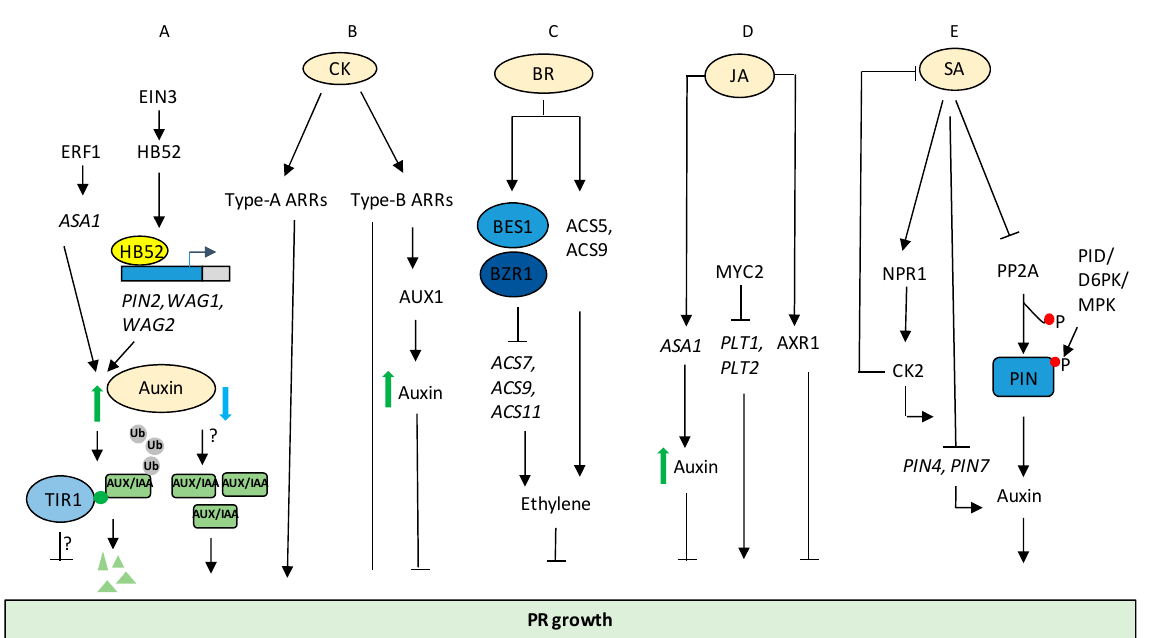
Figure 2. Regulation of primary root (PR) growth by various hormones and their crosstalk. ( A ) Auxin effects root growth in a concentration-dependent manner and interacts with ET signalling pathway to control PR elongation. Low concentration of auxin promotes PR growth probably via free AUX/IAAs, while high concentration inhibited PR growth through TIR1-mediated signalling via an unknown non-transcriptional mechanism ( B ) CK signalling modulates PR growth via AUX-1 mediated auxin translocation. ( C ) BR induces ET production via stabilizing ACS5, and ACS9 represses ET synthesis through BES1 and BZR1-mediated repression of ACS7 , ACS9 , and ACS11 to control PR growth. ( D ) MYC2, a DNA binding bHLH transcription factor in JA signalling, represses the transcriptional expression of PLT1 and PLT2. JA regulates expression of ASA1 and modulates auxin levels to cause root growth inhibition. JA and auxinsignalling occurs via AXR1 to control PR growth. ( E ) SA via NPR1-mediated signalling establishes an auto regulatory feedback regulation between CK2 and SA to link between SA signalling and auxin transport. SA also led to inhibition of PR elongation in NPR1-independent manner via affecting PP2A, leading to changes in PIN activity and auxin export, resulting in attenuation of root growth. Solid black arrow indicates confirmed pathway. Blue arrow indicates low levels of auxin, green arrow indicates high levels of auxin. Red circle indicates phosphorylation.